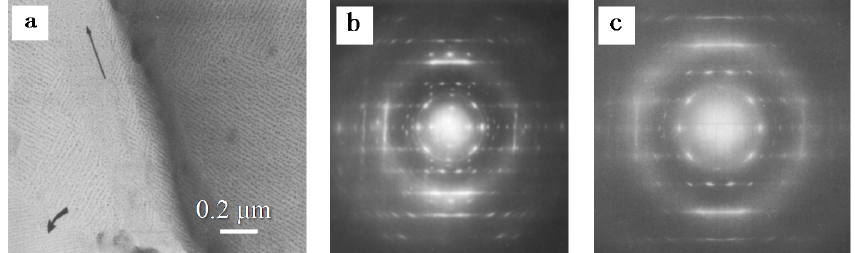
Figure 19. Phase contrast bright field electron micrograph ( a ) and corresponding electron diffraction patterns before ( b ) and after ( c ) the complete II to I phase transition of iPBu crystallized on benzoic acid substrate. The straight arrow in part ( a ) indicates the b -axis direction of the benzoic acid substrate crystals. The transformation is found to be accelerated by the electron bombardment. Reproduced